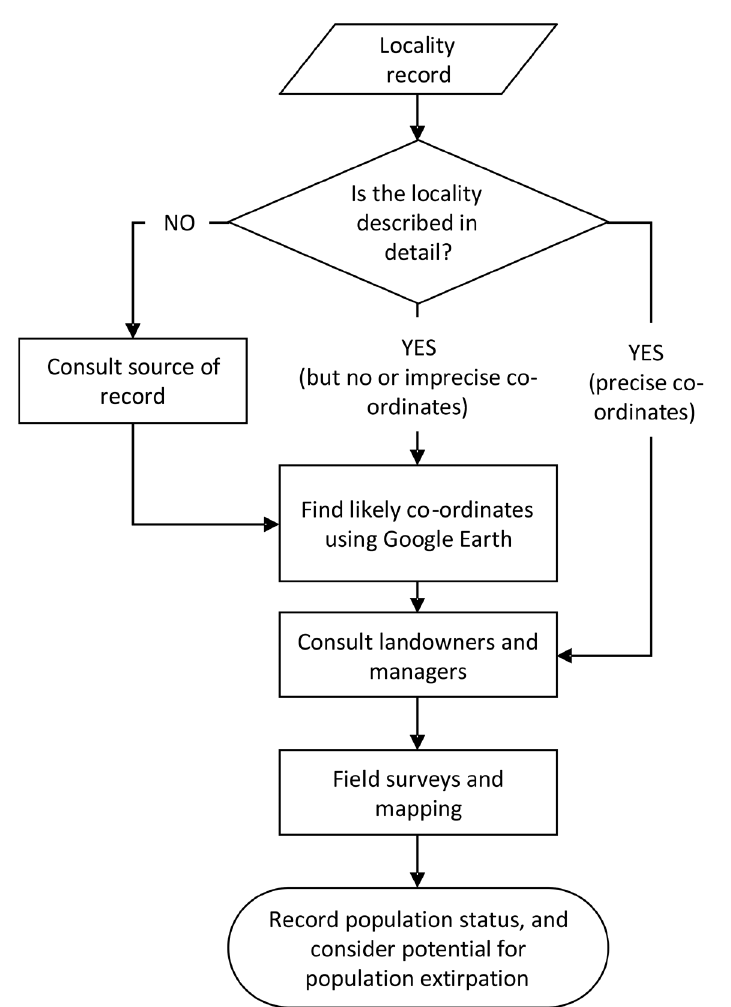
Figure 1. The protocol used in this paper for dealing with records of Australian Acacia species in South Africa. The protocol resulted both in an inventory of species in South Africa and recommendations for incursion